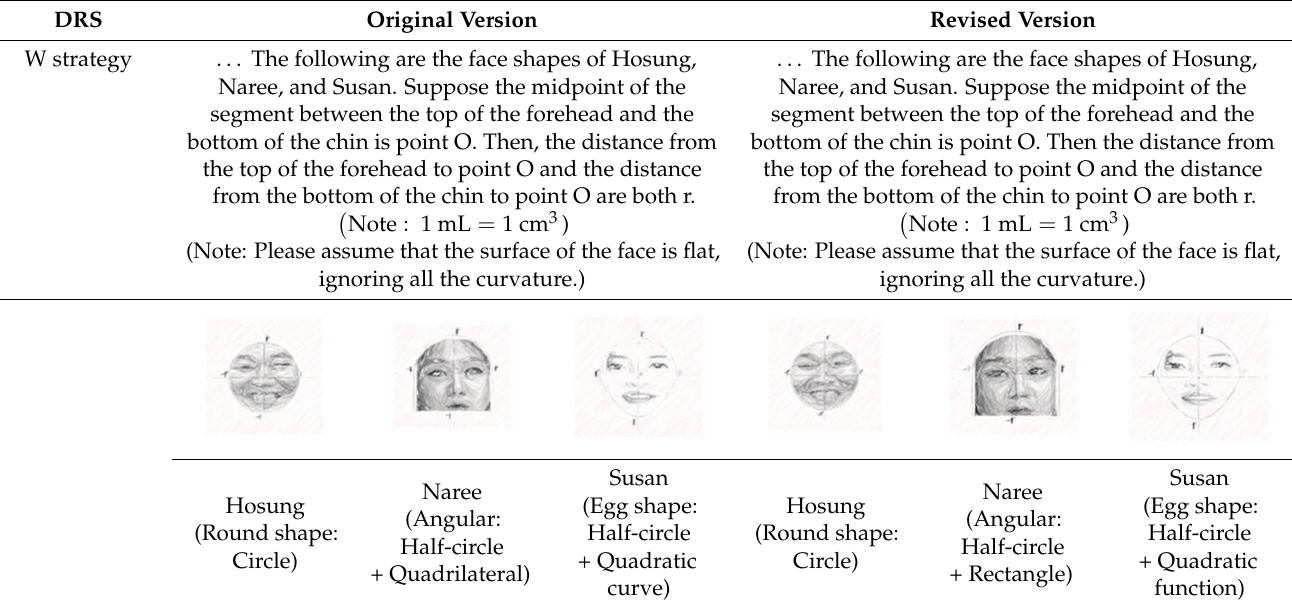
Table 8. W Strategy (Using Words Appropriate for Student Understanding).